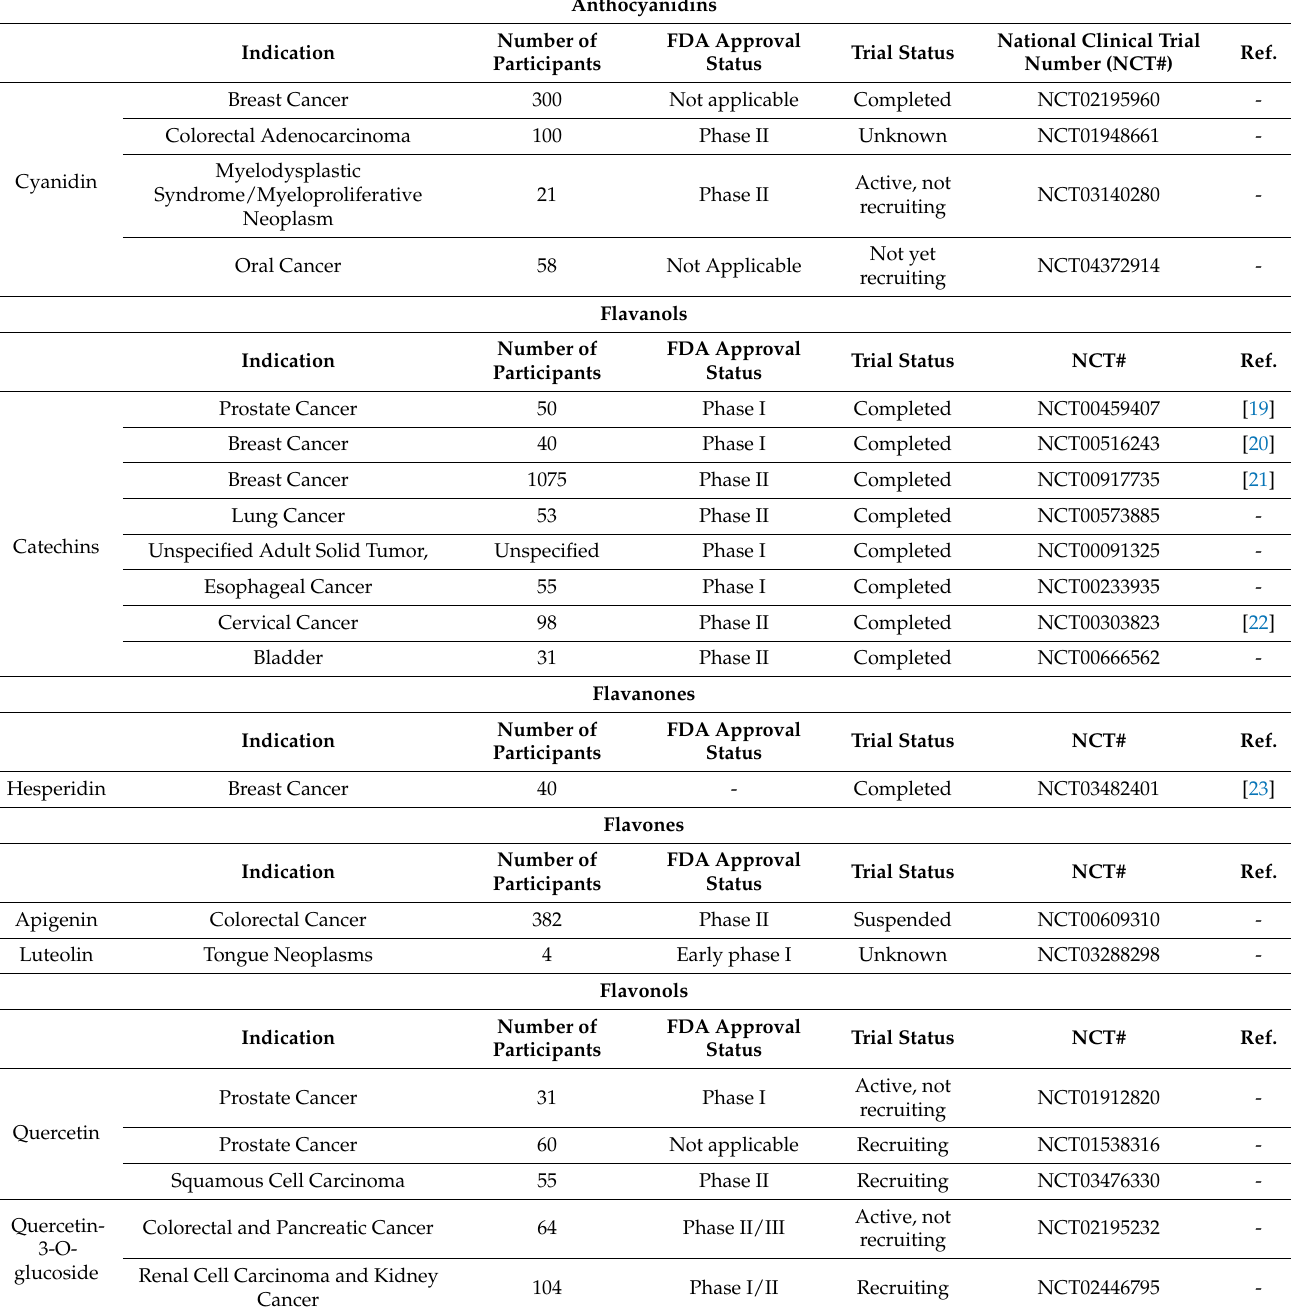
Table 2. Clinical trials based on flavonoids administration for